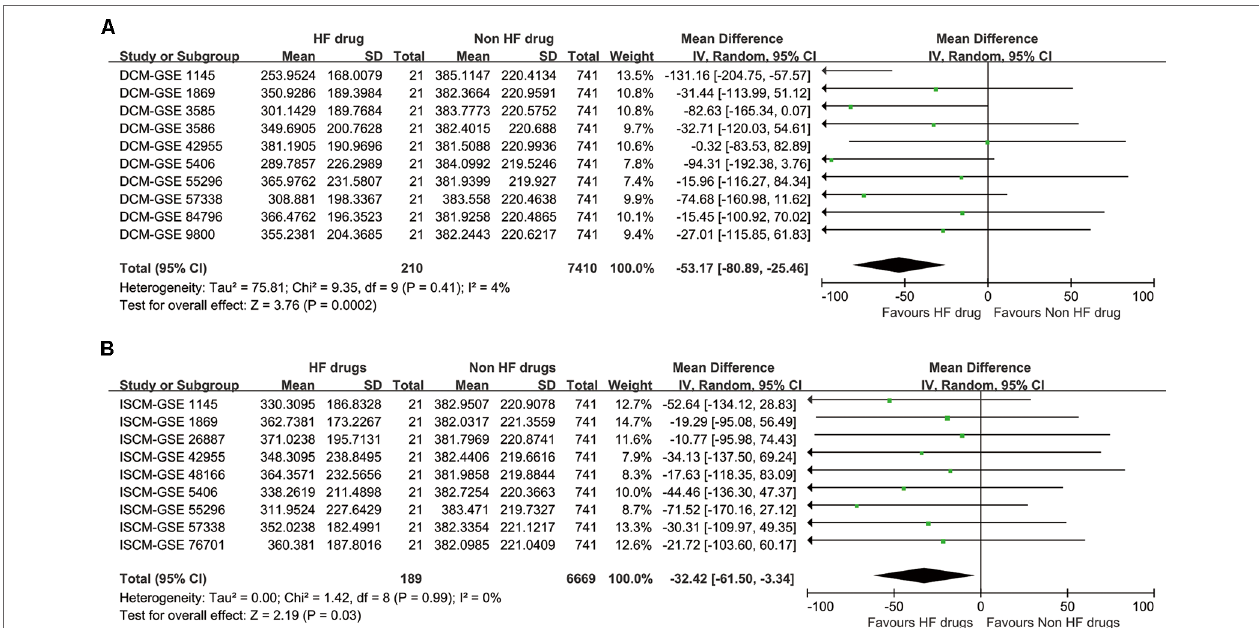
FIGURE 2 | The synthesized result of the enrichment analysis. (A) For dilated cardiomyopathy (DCM). (B) For ischemic cardiomyopathy (ISCM).